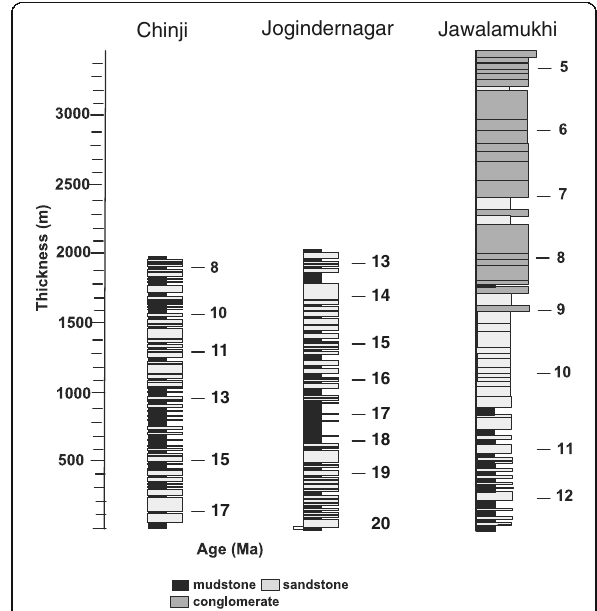
Fig. 6 Stratigraphic columns of three of the key foreland sections discussed in this paper, showing thickness, lithology and depositional ages. Chinji data are from Johnson et al. (1985), Jognidernagar data are from White et al. (2002), while Jawalamukhi data are from Najman et al. (2009). Note that the only well-studied section post-dating 8 Ma in the western Himalaya is at Jawalamukhi. None the sections extend older than 20 Ma meaning that they cannot be used to constrain changing erosion during the onset of rapid Greater Himalayan exhumation or the proposed intensification of the monsoon after ~24